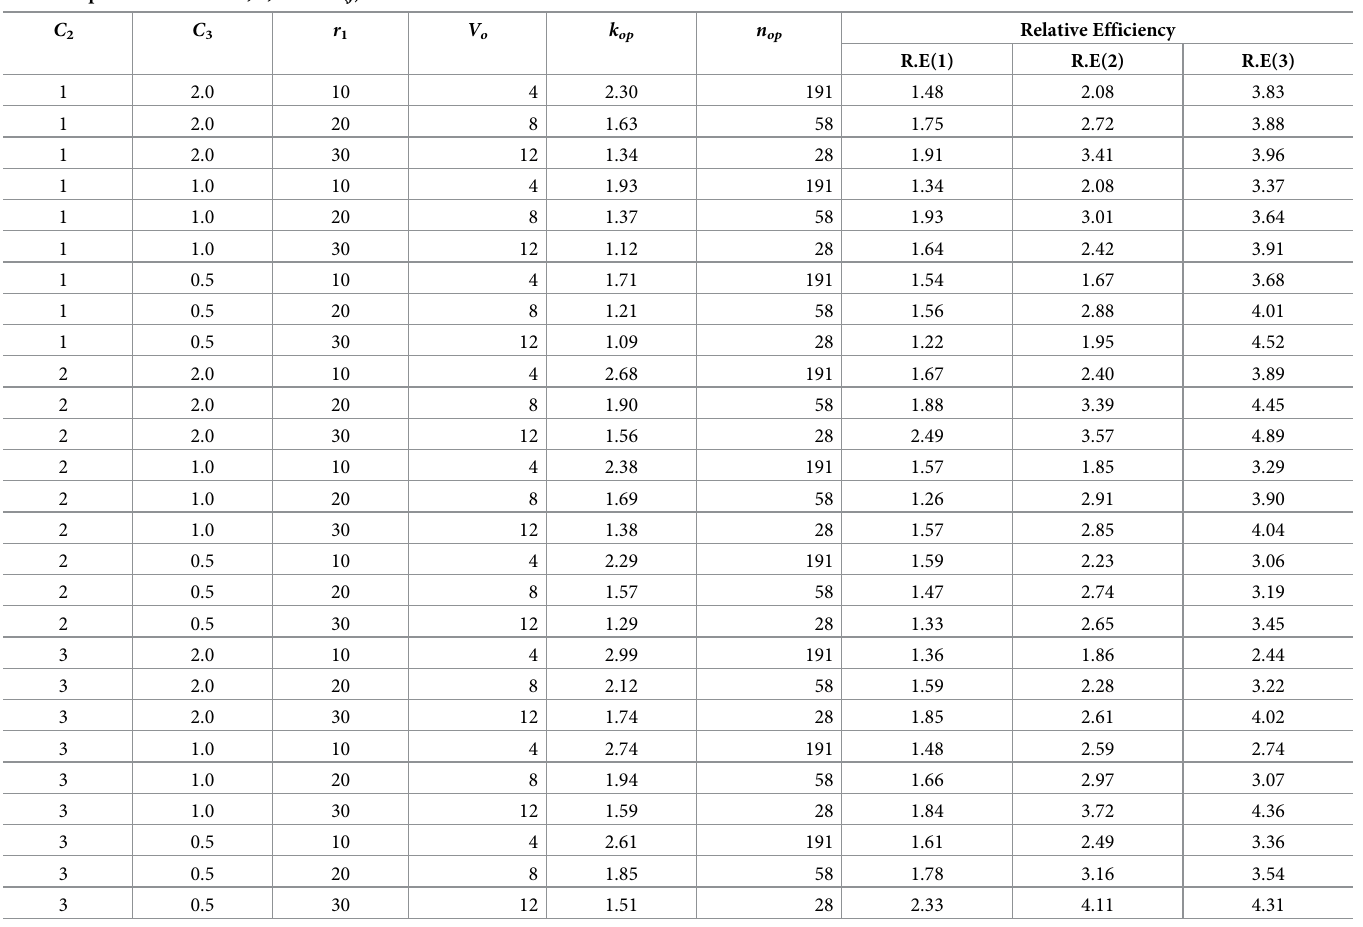
Table 1. Optimum values of k , n , and R.E( j ) w.r.t. ^� u �